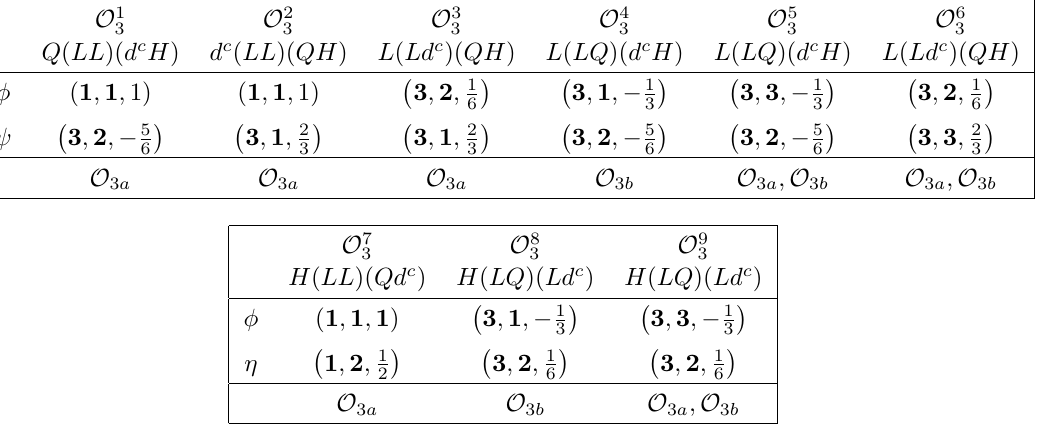
and [31]. Here the models in the top O 3 a O 3 b